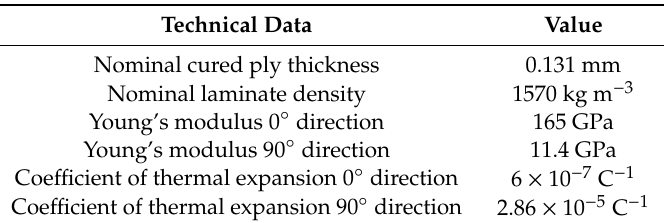
Table 2. Hexply 8552 data.